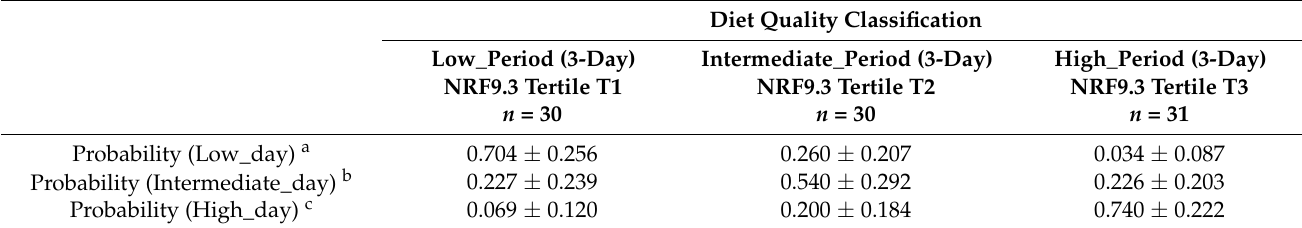
Table 3. Verification of stability in diet quality classification based on the NRF9.3.